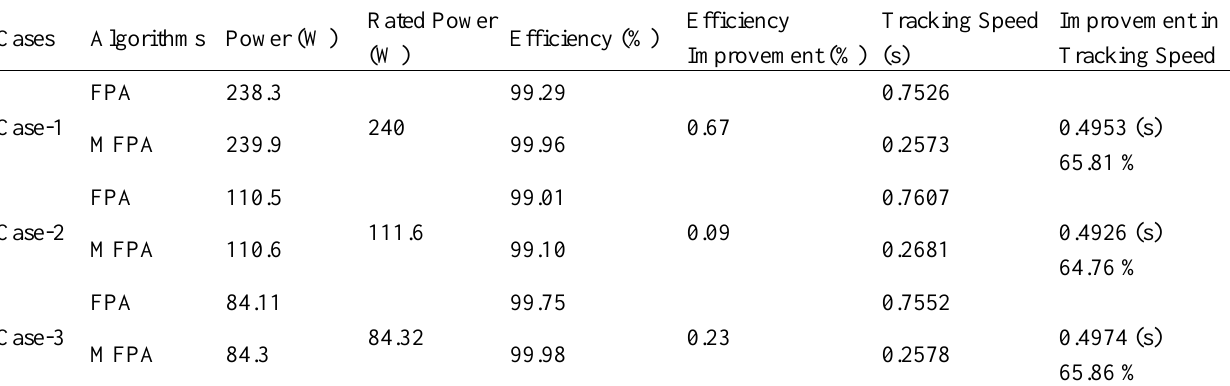
Performance Assessment of FPA and MFPA Algorithms